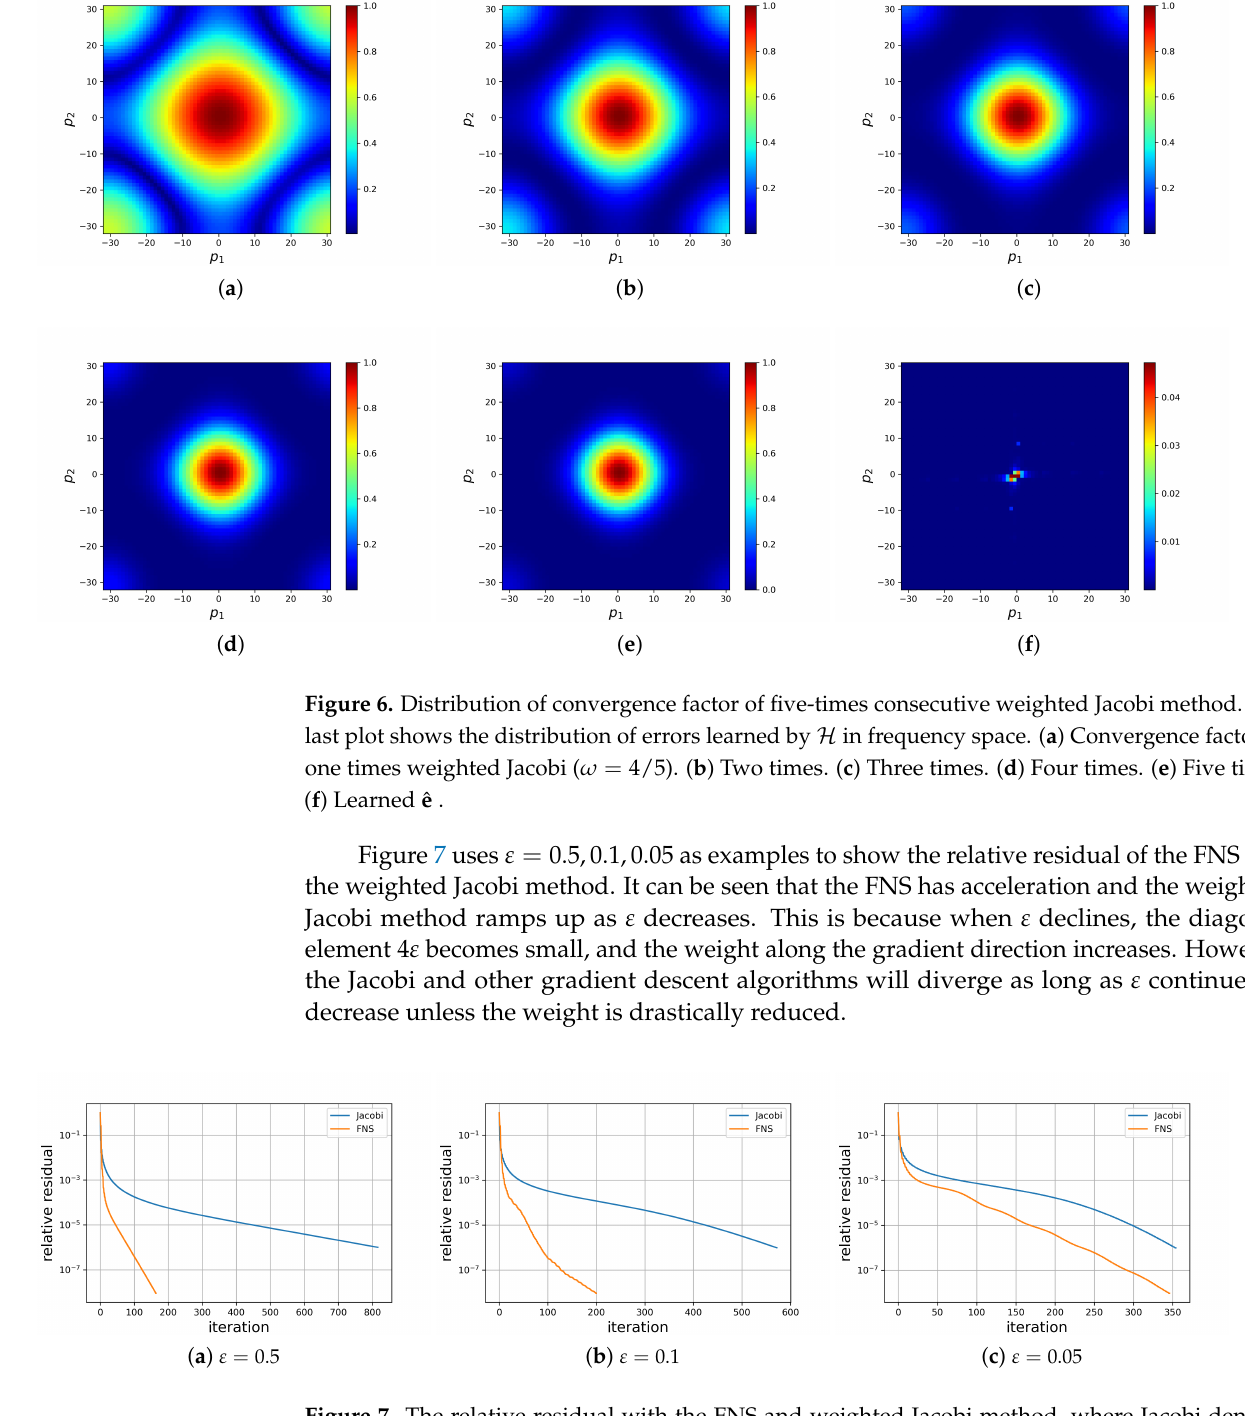
Figure 7. The relative residual with the FNS and weighted Jacobi method, where Jacobi denotes five-times the consecutive weighted Jacobi